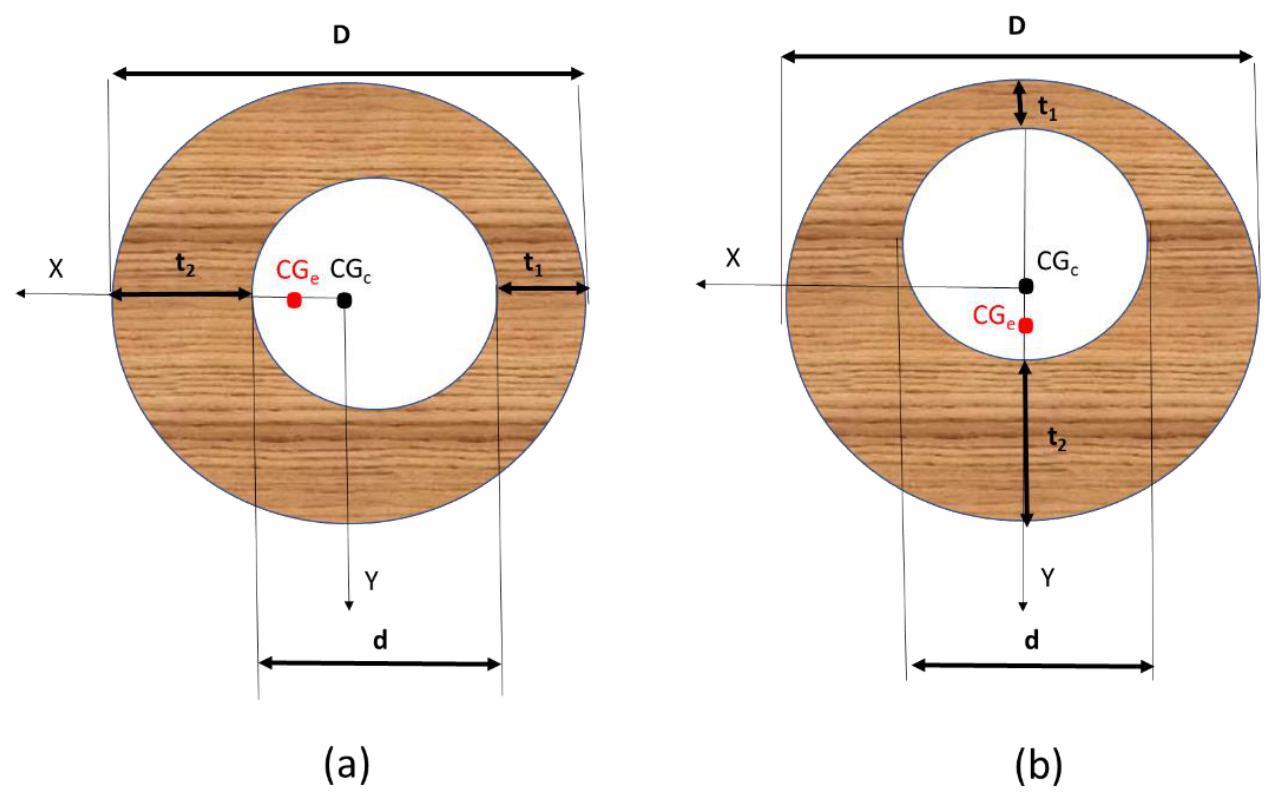
Figure 7. Schematic representation of a disc with a circular cavity with eccentricity in axe X ( a ) and with eccentricity in axe Y ( b ). t 1 and t 2 = thickness of the wall remaining; CG c = center of gravity (in red)